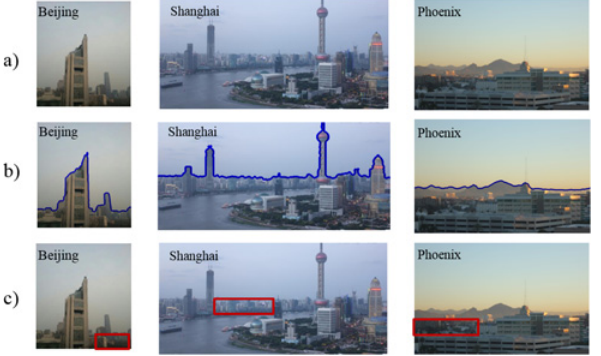
Fig 4. Sample photos in our haze detection database. a) Photos captured at Beijing, Shanghai and Phoenix respectively. b) Boundary lines (blue lines in b) between distant buildings and sky. c) Selected ROIs (red boxes). Reprinted under a CC BY license, with permission from [Yi Zou], original copyright